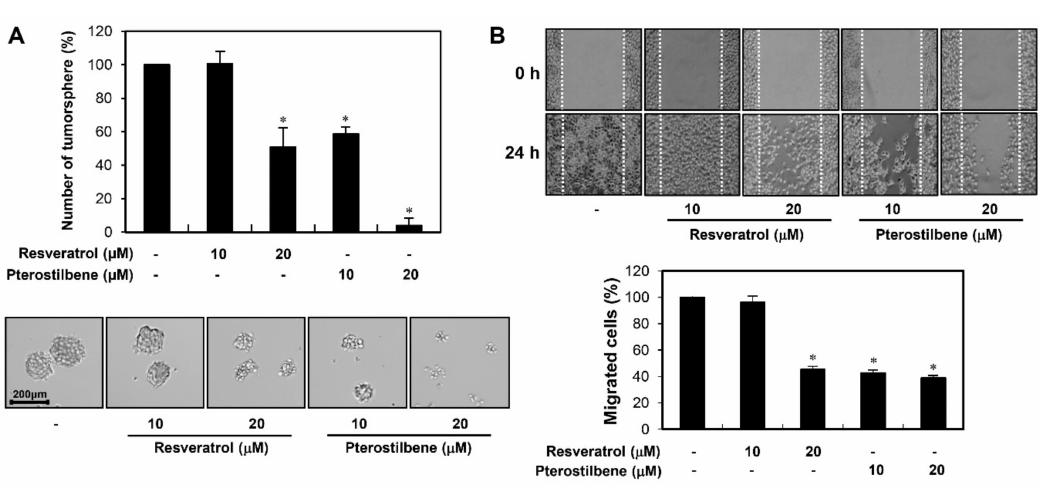
Figure 6. E ff ects of resveratrol and pterostilbene on the tumorsphere-forming ability and migration of cervical cancer stem cells (CSCs). ( A ) HeLa cancer stem-like cells were treated with the two compounds (10 and 20 µ M) and incubated with the CSC culture media for eight days. The number of formed tumorspheres in each well was counted under a microscope. ( B ) HeLa cancer stem-like cells were seeded into laminin-coated culture plate and incubated with the CSC culture media in the absence or presence of resveratrol and pterostilbene (10 and 20 µ M) for 24 h. The cells that migrated into the gap were counted under an optical microscope. White lines indicate the edge of the gap at 0 h. * p < 0.05 versus the